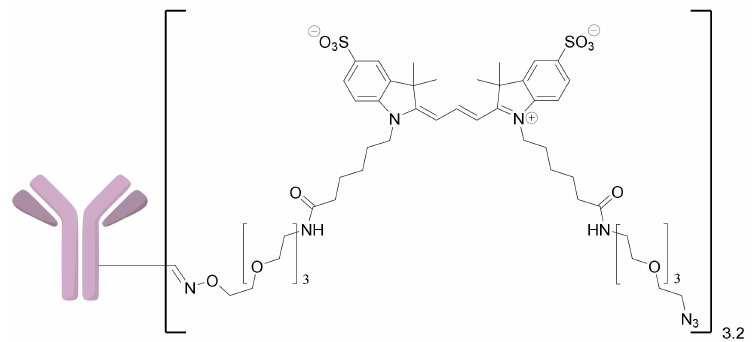
Figure 10. The structure of conjugate 5 . Conjugate 9 The 6H8 antibody (0.90 mg, 6.0 nmol) was modified with reagent 8 according to general procedure A; 0.46 mg (3.1 nmol, 51%) of conjugate 9 (Figure 11) were obtained.